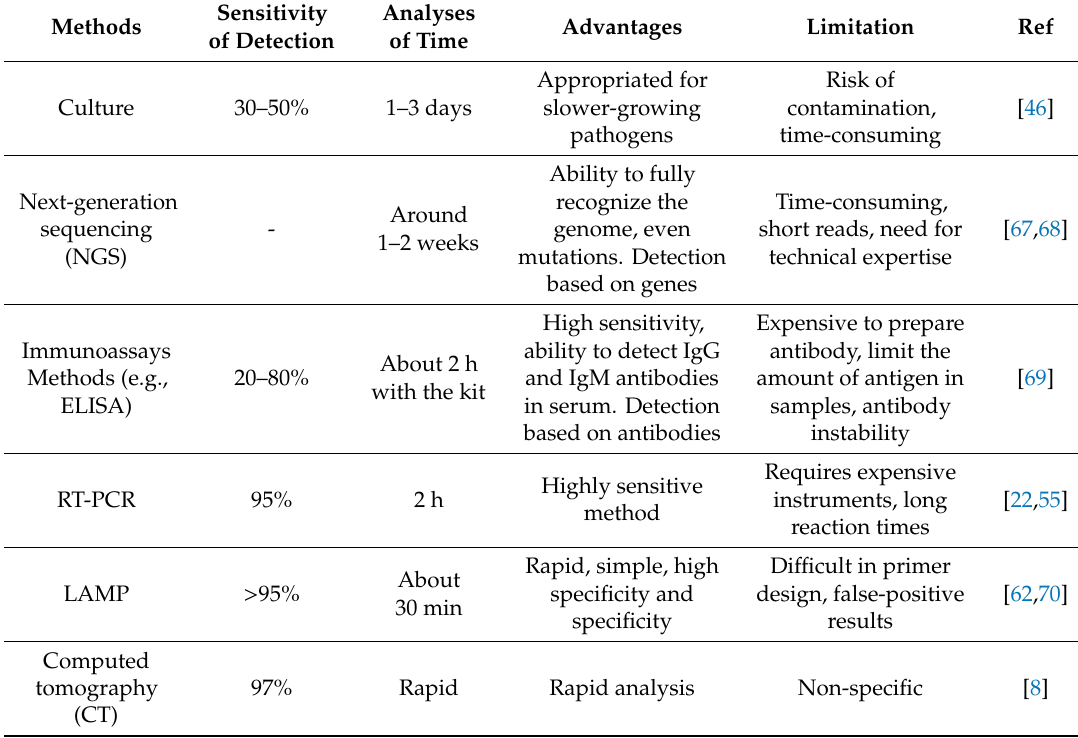
Table1. Sensitiveofdetection, advantages, andlimitationsofcurrentmethodsindiagnosisofCOVID-19.